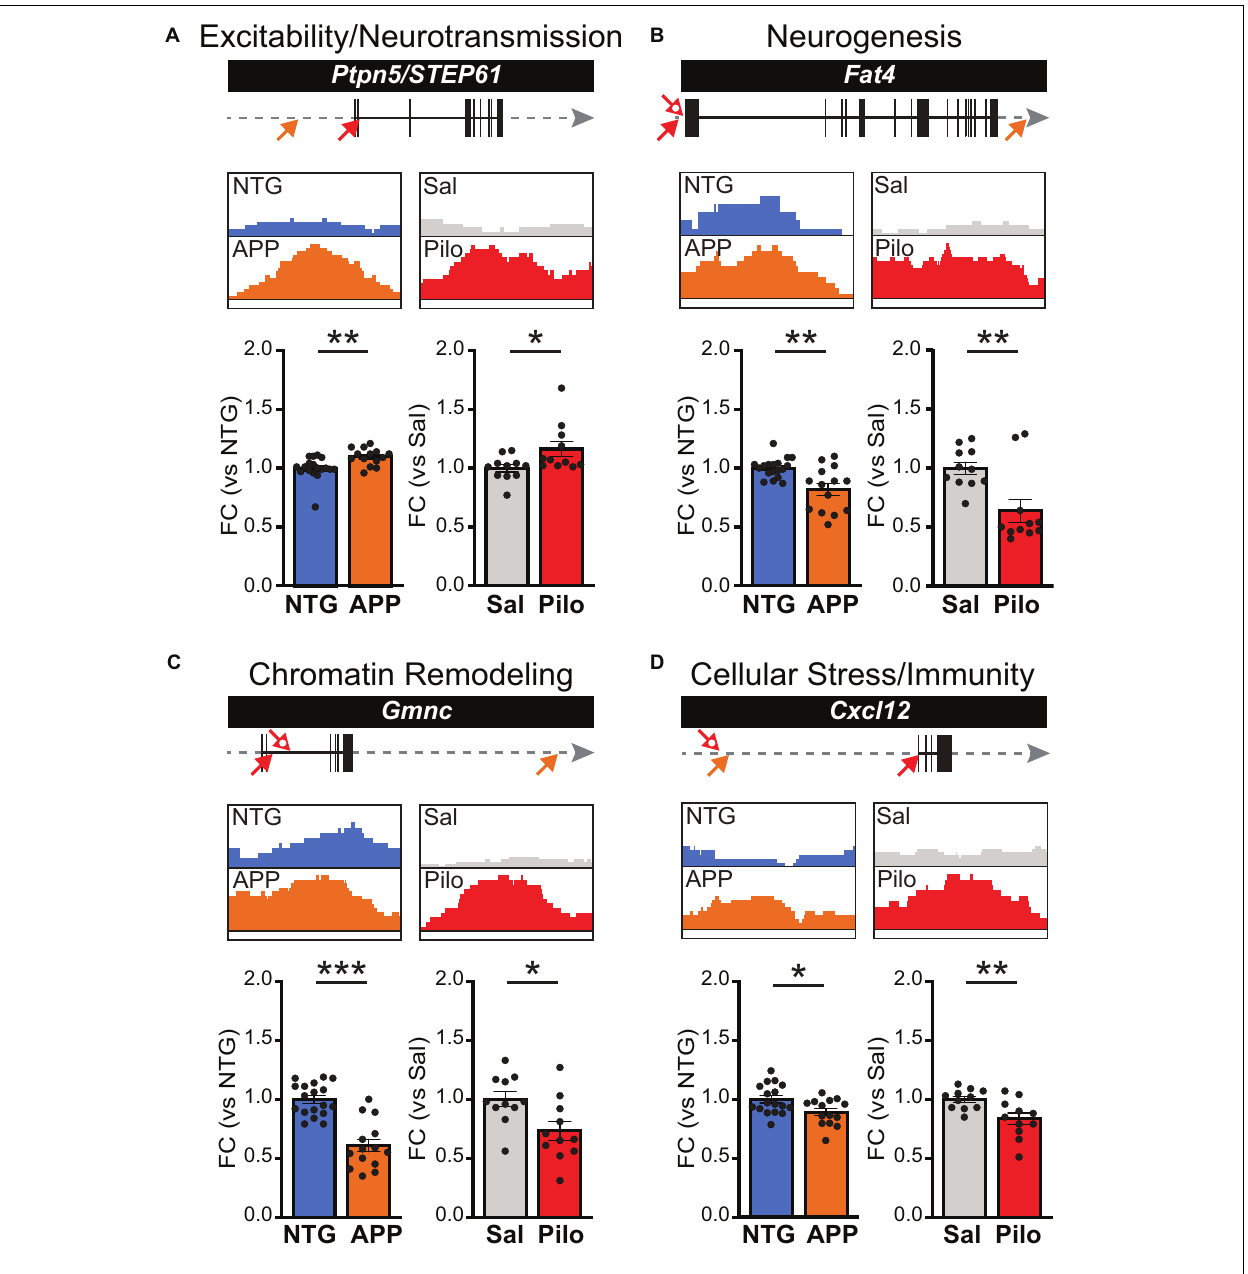
FIGURE 6 | (cid:49) FosB target genes bound in both APP mice and Pilo mice have altered mRNA expression levels. (cid:49) FosB binding peaks and corresponding mRNA expression levels for example target genes from the subset of the 442 targets bound in both APP and Pilo mice. For each gene, locations of significant (cid:49) FosB ChIP-seq binding peaks ( p < 0.0001) in APP (orange) and Pilo (red) mice are marked on gene tracks by arrows (top; closed arrow, strongest peak; open arrow, additional peaks). Gray arrow indicates 135 kb stretch of genome. The strongest binding peaks in APP and Pilo mice, along with corresponding locations in their respective controls, are depicted in boxes (middle). Fold change (FC) of mRNA expression relative to respective controls (bottom) are shown for NTG and APP mice (left, n = 14–18/genotype) and Sal and Pilo mice (right, n = 11/group). (A–D) (cid:49) FosB binding peaks and RT-qPCR mRNA expression levels for example genes related to (A) Excitability and Neurotransmission, (B) Neurogenesis, (C) Chromatin Remodeling, and (D) Cellular Stress and Immunity. * p < 0.05, ** p < 0.01, *** p < 0.001, Student’s unpaired two-tailed t -tests.